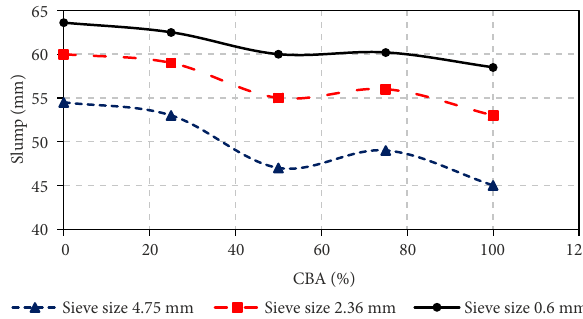
Figure 2. Influence of fine aggregate size and CBA replacement ratio on the workability of LFC